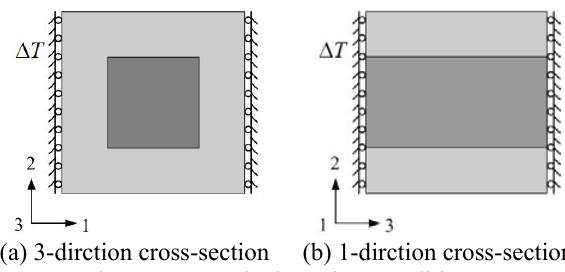
Fig. 3. RVC under boundary condition 2